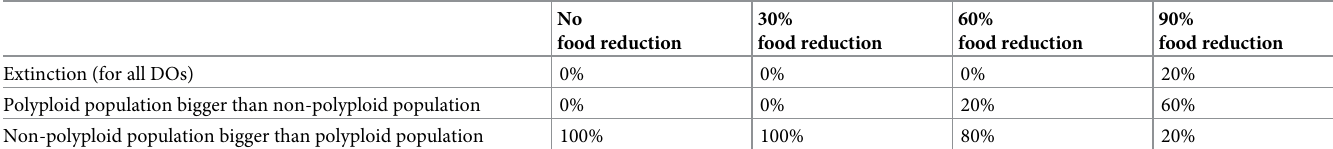
Table 2. Summary of results from evolution simulation experiments under a scenario of fixed food reduction. For every food reduction group, 10 simulations were run for up to 1000 time steps, or until either the polyploid or non-polyploid subpopulations become extinct, or started growing